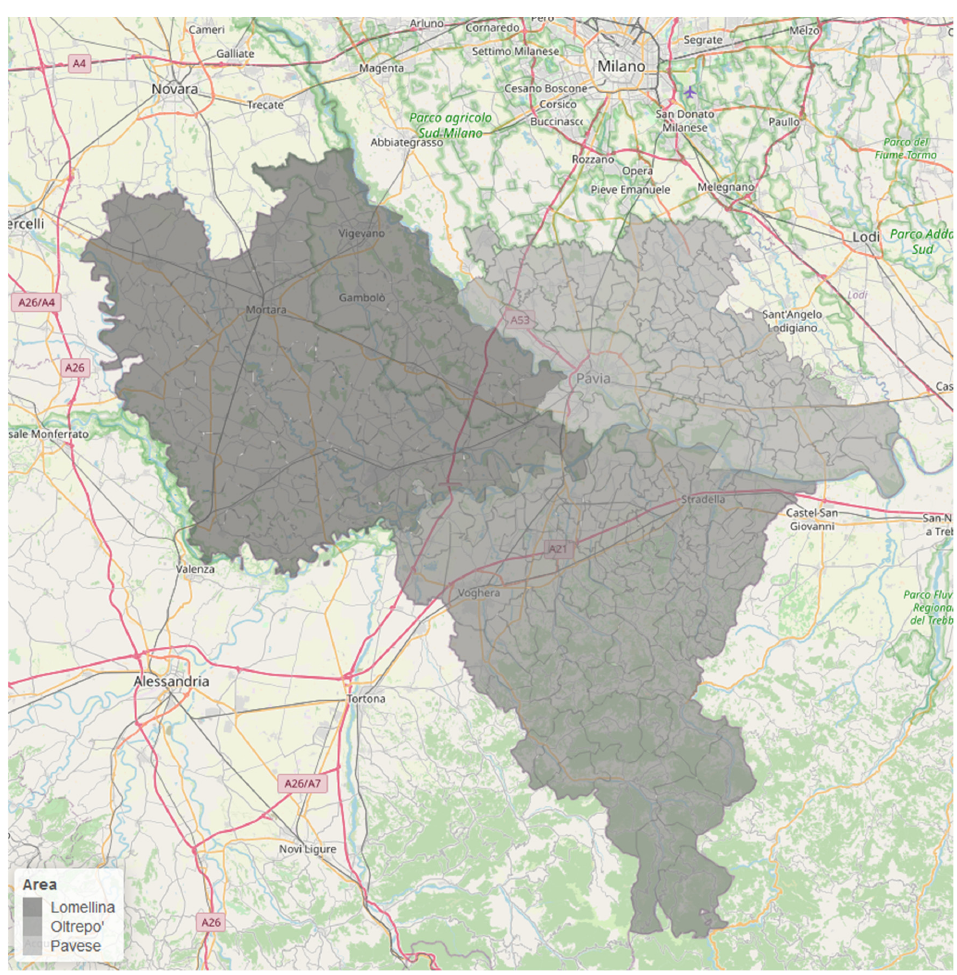
Figure 1. Map of study area with the three subareas.